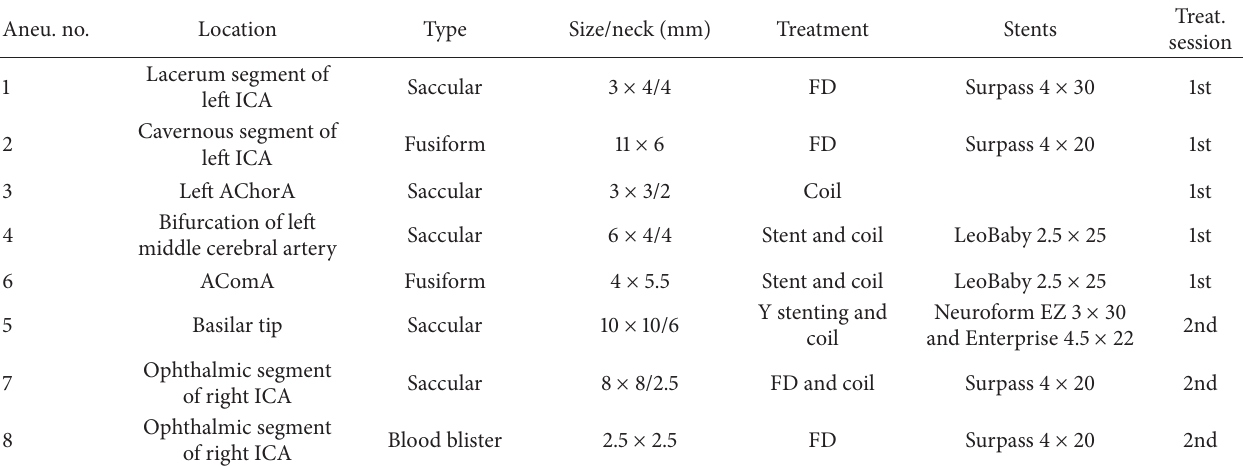
Table 1: Aneurysm locations, characteristics, and treatment techniques. Aneu.